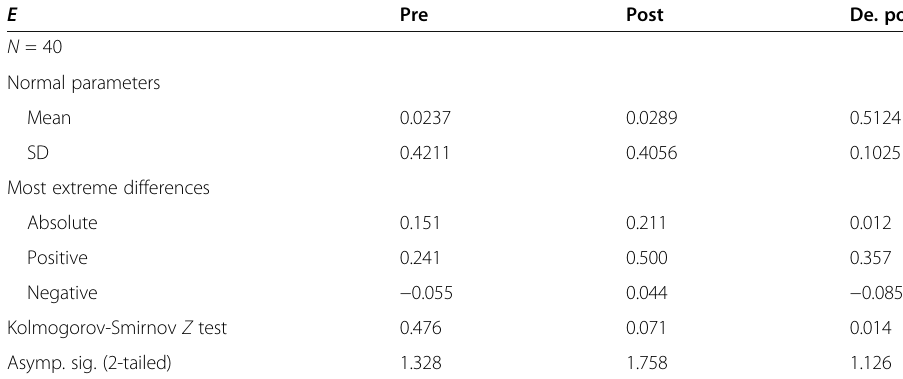
Table 4 The one-sample Kolmogorov-Smirnov test for normality of data E Pre N = 40